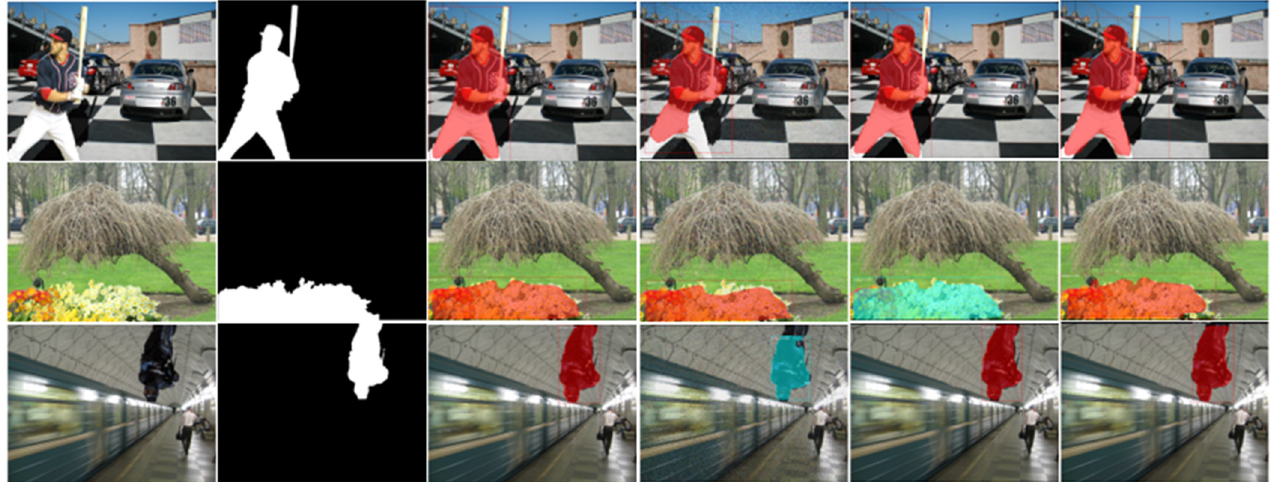
Figure 6. Exemplar visual results on NIST16 dataset. From left to right: the first two columns are tampered images and Ground-Truth, the third to fifth columns are results of the tampered images, tampered images with noise (0, 0.02), blur (3 × 3, 0.5) and JPEG (50).